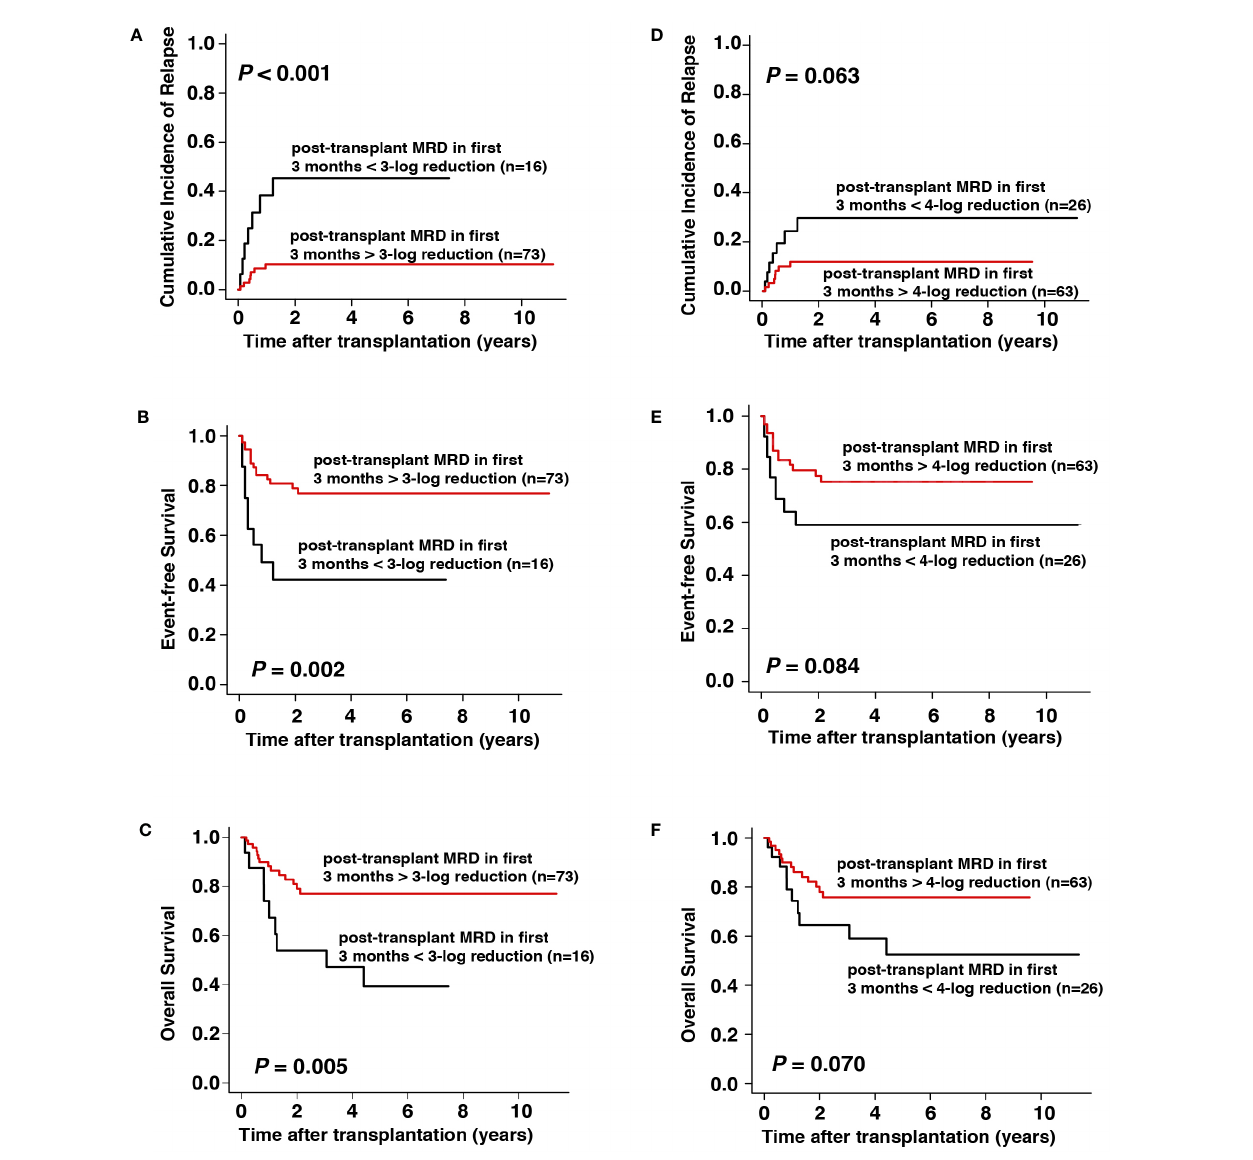
FIGURE 3 Prognostic impact of MRD within the fi rst 3 months after allo-HSCT on outcomes. (A – C) CIR, EFS, and OS with cut-off value set at 3-log reduction, (D – F) CIR, EFS, and OS with cut-off value set at 4-log